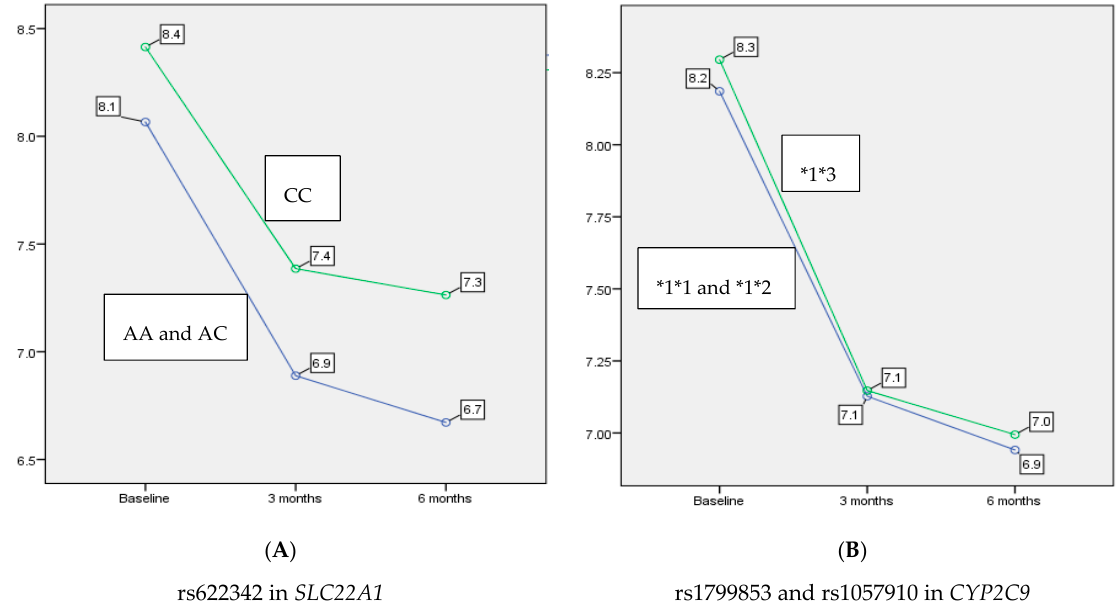
Figure 1. The main effect of rs622342 in SLC22A1 and rs1799853/rs1057910 in CYP2C9 on reducing the average of HbA1c after 3 and 6 months. rs622342 in SLC22A1 was significantly associated with HbA1c levels ( p < 0.001). rs1799853 and rs1057910 in CYP2C9 did not show any significant effect on HbA1c levels ( p = 0.623). HbA1c: glycated hemoglobin; FBS: fasting blood sugar.